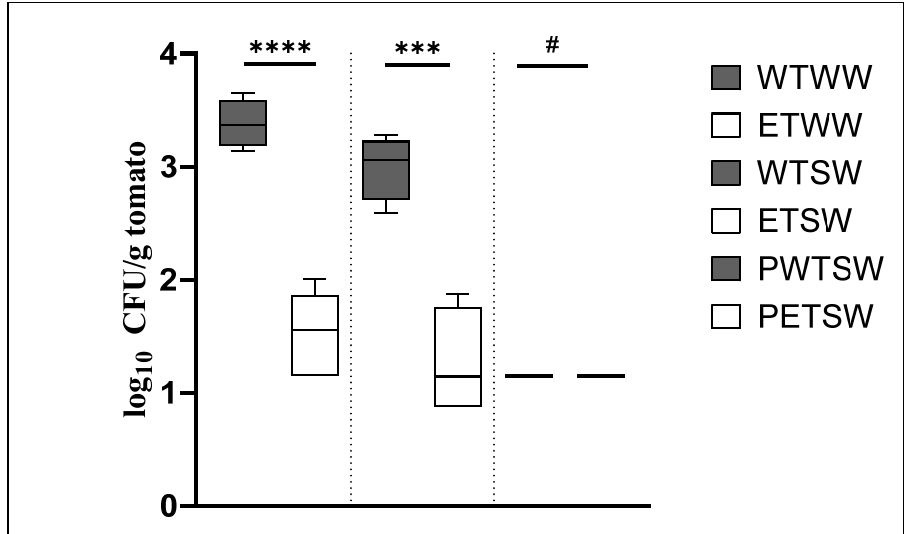
Figure 3. Recovery of S. Typhimurium FSL R6-0020 from the tomatoes by means of silwet L-77. Log reductions were calculated between the 8% EAA wash and the H 2 O wash. The log 10 CFU/g tomato data are plotted for each of the samples (grey bars, H 2 O; white bars, EAA). The asterisks are indicative of the significance of the p -values from the t -tests (**** <0.001, *** 0.0004, # not applicable as both groups yield identical data). WTWW, FSL R6-0020 with H 2 O wash and H 2 O recovery; ETWW, FSL R6-0020 with EAA wash and H 2 O recovery; WTSW, FSL R6-0020 with H 2 O wash and silwet L-77